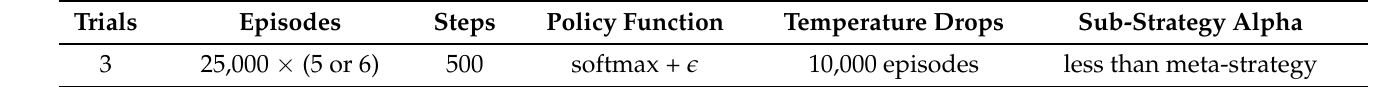
Table 3. Hyperparameters of experimental 2.